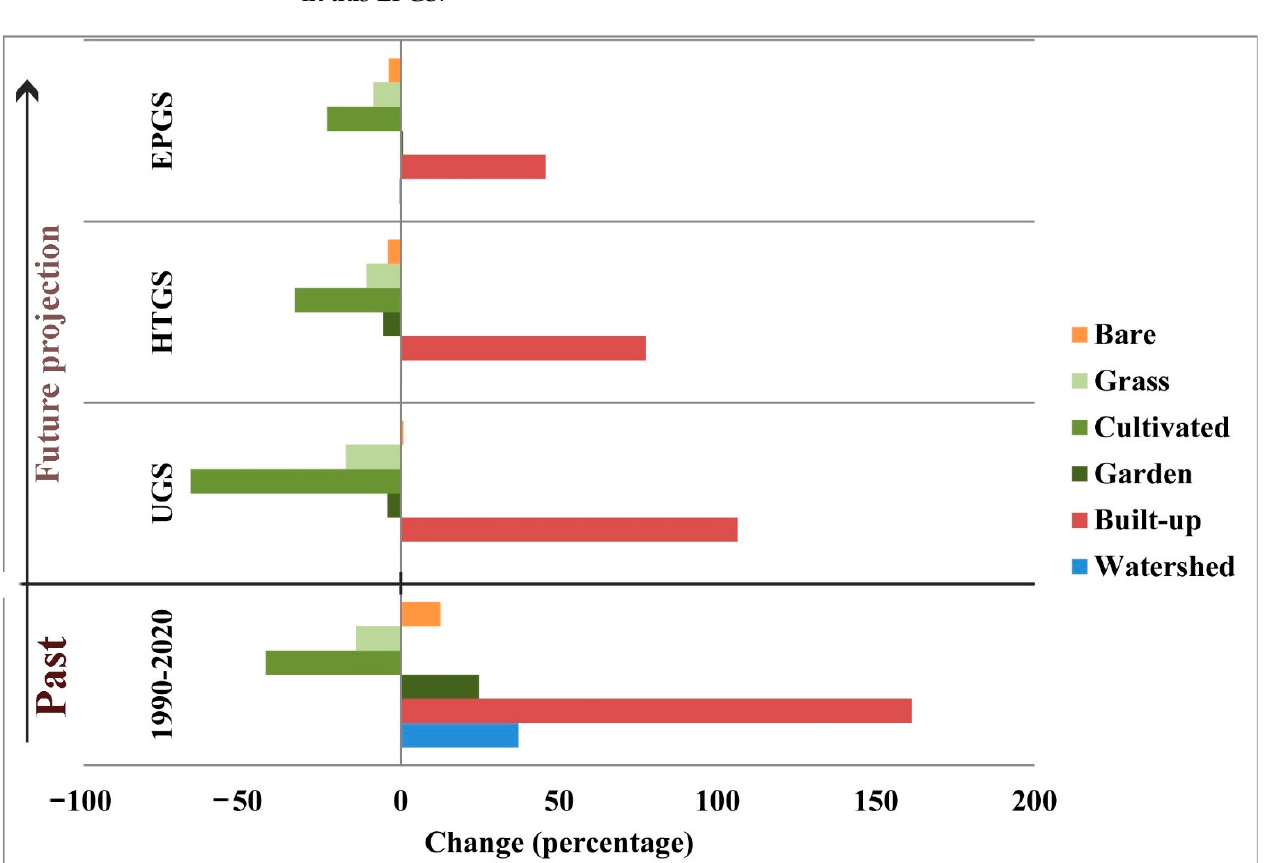
Figure 12. Percentage of changes in land use from 1990 to 2050.